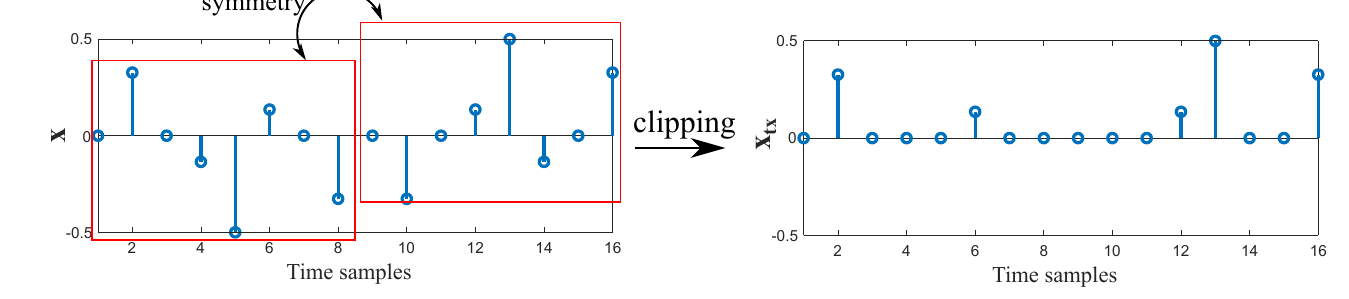
Figure 7. Time-domain ACO-OFDM